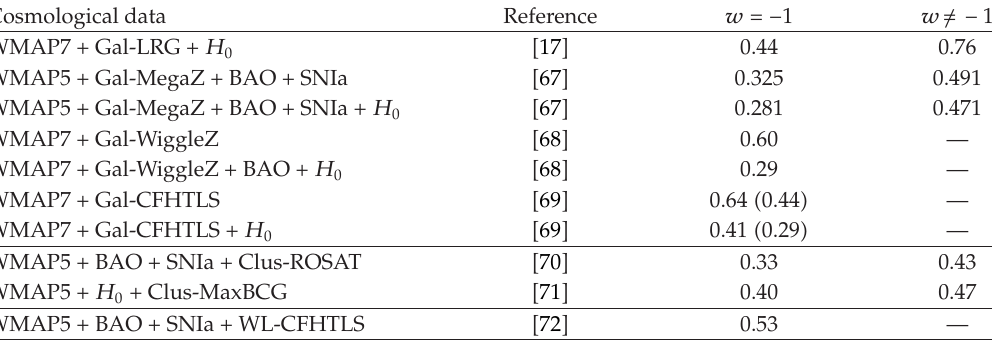
Table 1: 95% CL upper bounds on the total neutrino mass M ν in eV, for various combinations of CMB, homogeneous cosmology, and LSS data sets. The first seven lines refer to galaxy power spectrum measurements, the next two lines to cluster mass function measurements, the last line to a weak lensing survey. WMAP5 or 7 stands for WMAP 5 or 7-year data. H 0 refers to the direct measurement by the HST Key Project (cid:4) 64 (cid:5) and BAO to estimates of the scale of Baryon Acoustic Oscillations at various